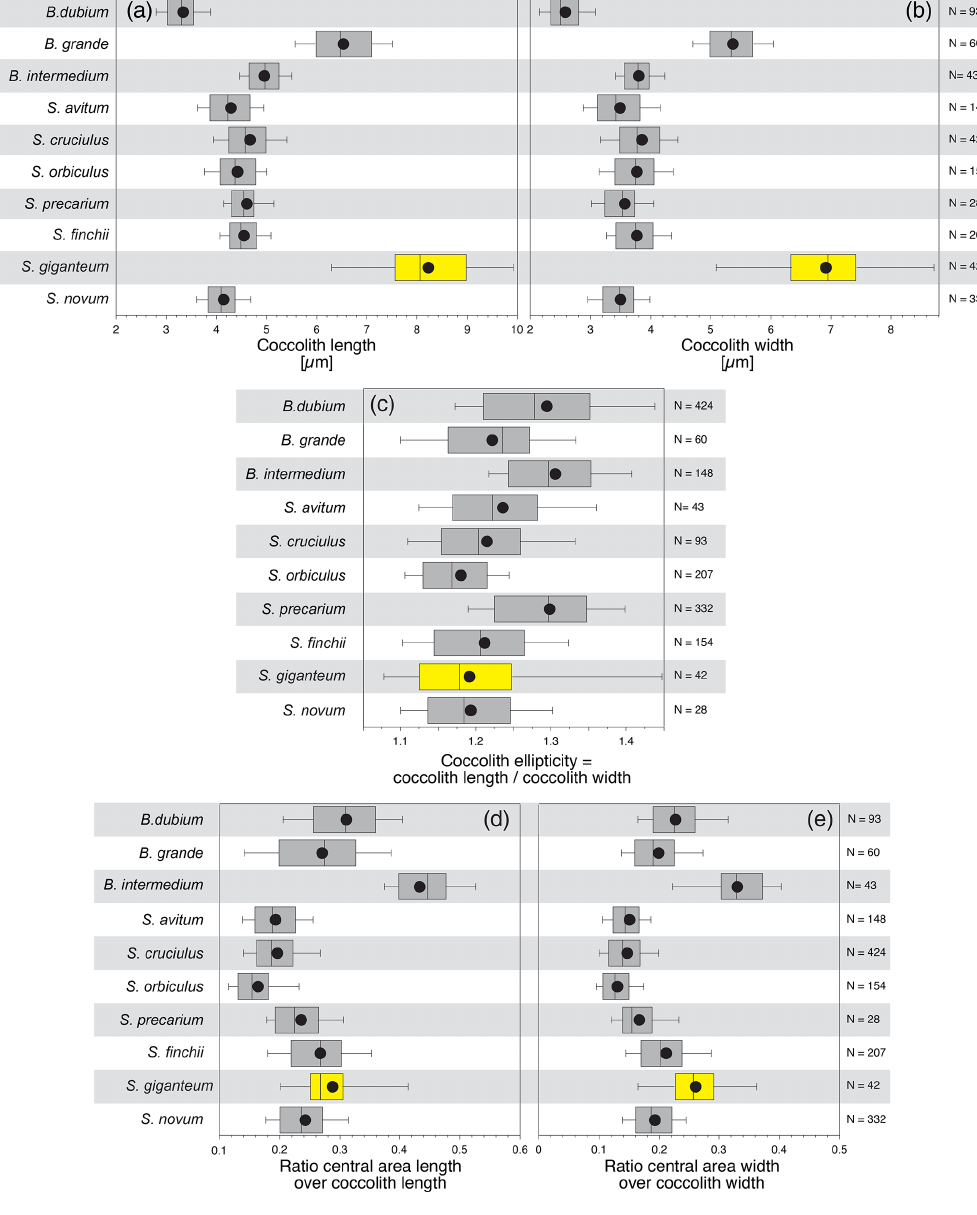
Figure 4. The size and geometry of Similiscutum giganteum sp. nov. are compared to similar parameters measured for other Lower Jurassic Biscutaceae after the dataset of Mattioli et al.